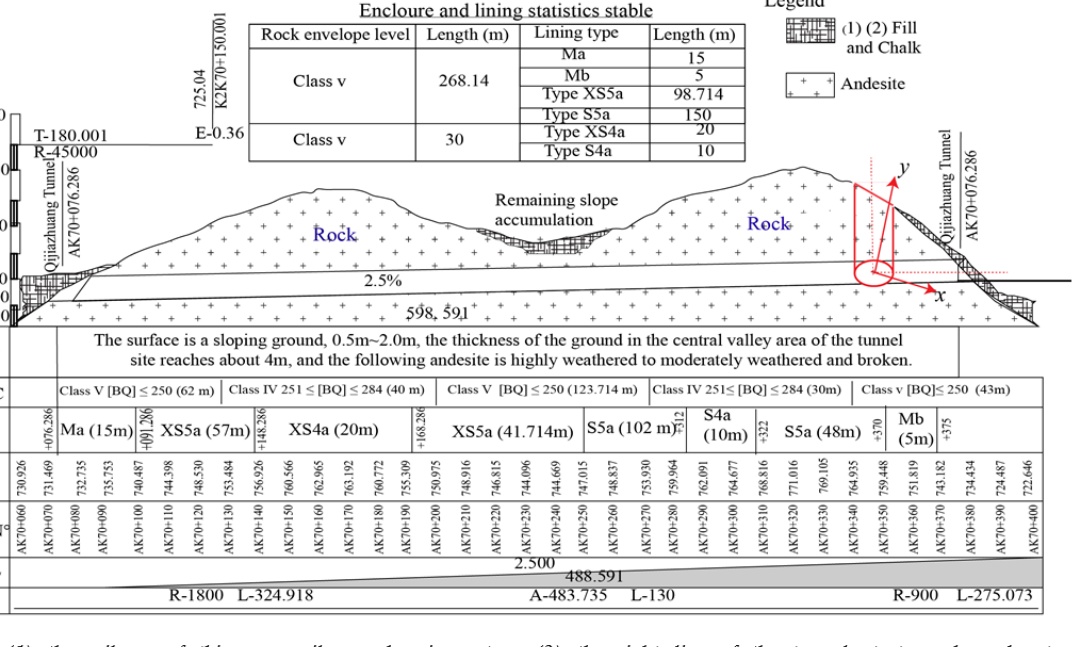
Figure 20. 2 – 4 longitudinal section of Qijiazhuang Tunnel